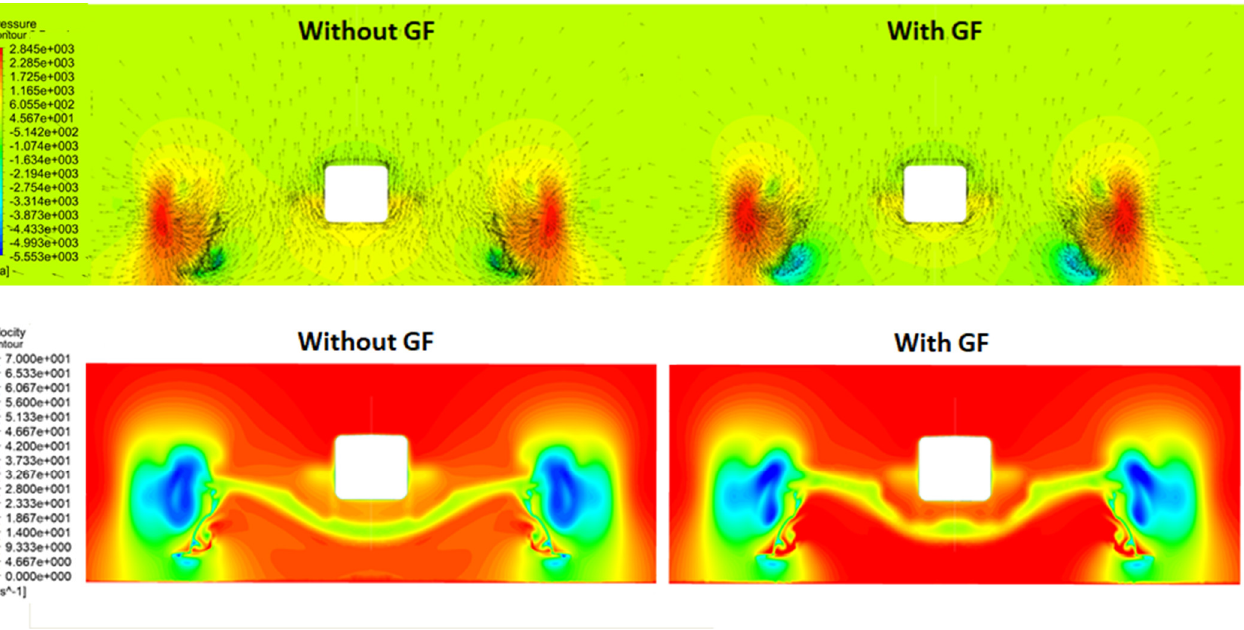
Figure 10. Comparison on the x 2 plane of distributions between the case with and without GF: ( above ) pressure contours with velocity vectors, ( below ) velocity contours.